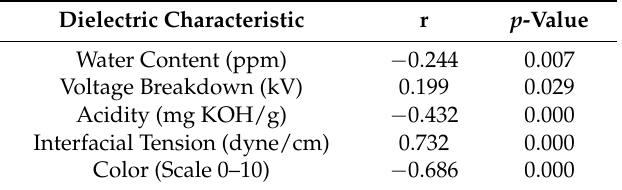
Table 5. The correlation coefficients of DP against the dielectric characteristics for oil-filled transformers.